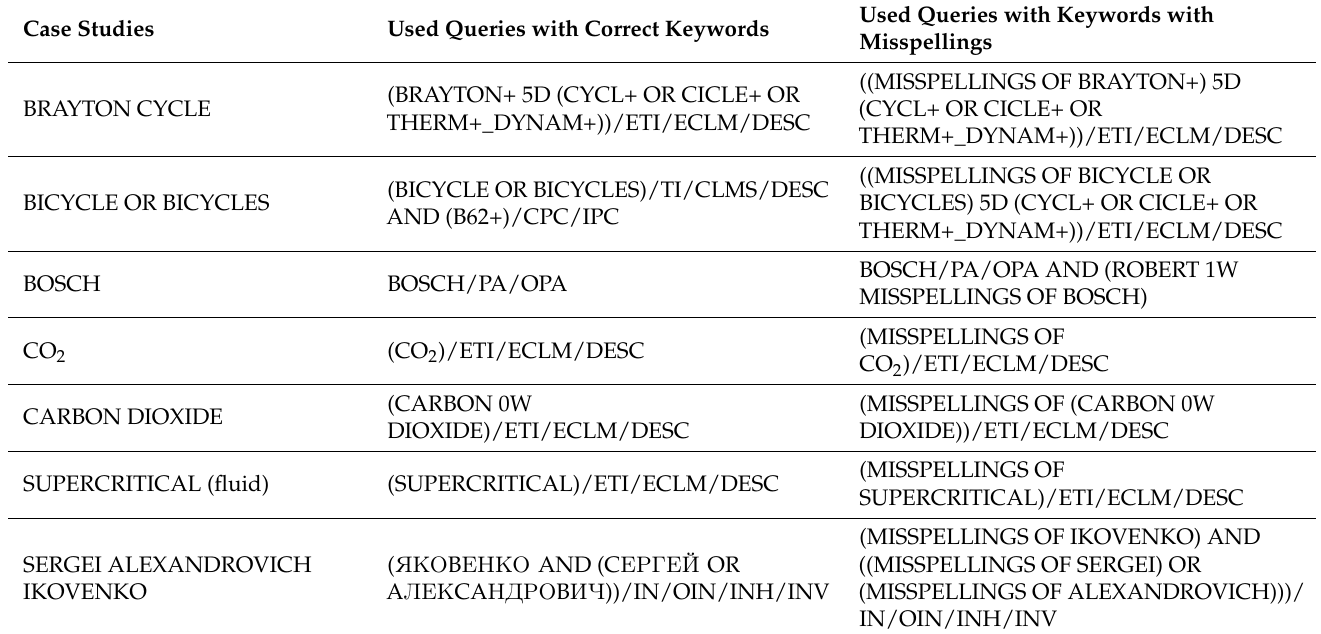
Table 3. Queries with correct keywords and keywords with misspellings used in the considered case studies.